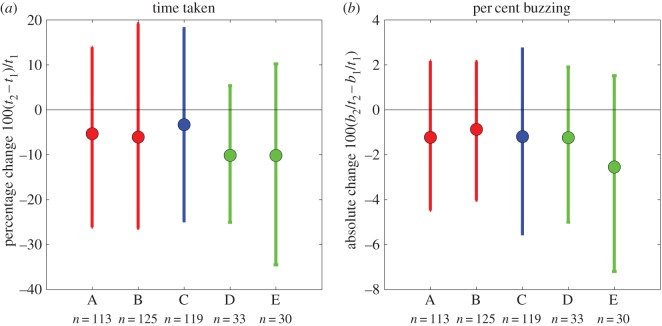
Improvements on the coordination task after viewing TV. Panel (a) examines changes in total time taken (t). Panel (b) examines changes in time spent buzzing (b). If t1 is the total time taken to complete the task before viewing TV and b1 is the time spent buzzing, and t2, b2 are the equivalent after viewing TV, then panel (a) plots percentage increase in time, 100(t2−t1)/t1, while panel (b) plots absolute change in percentage points of time spent buzzing, 100(b2/t2−b1/t1). We did not express this as a percentage change, because this could be infinite (b1 was zero for some participants). In both panels, negative values represent an improvement, i.e. less time taken/less time spent buzzing after viewing TV. Symbols represent the mean over all participants in the group for whom data were available (n shown below each group); error bars show the range from the 16th to 84th percentiles (equivalent to plotting ±1 s.d. for normally distributed data). Groups: A, active S3D; B, passive S3D; C, 2D control; D, E, ‘fake 3D’.